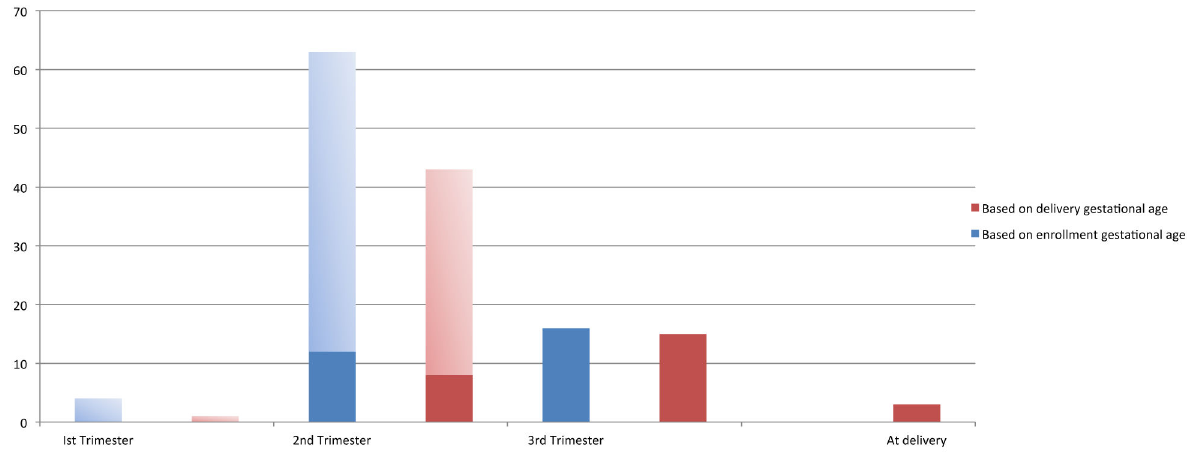
Figure 1. Number of participants with malaria during each